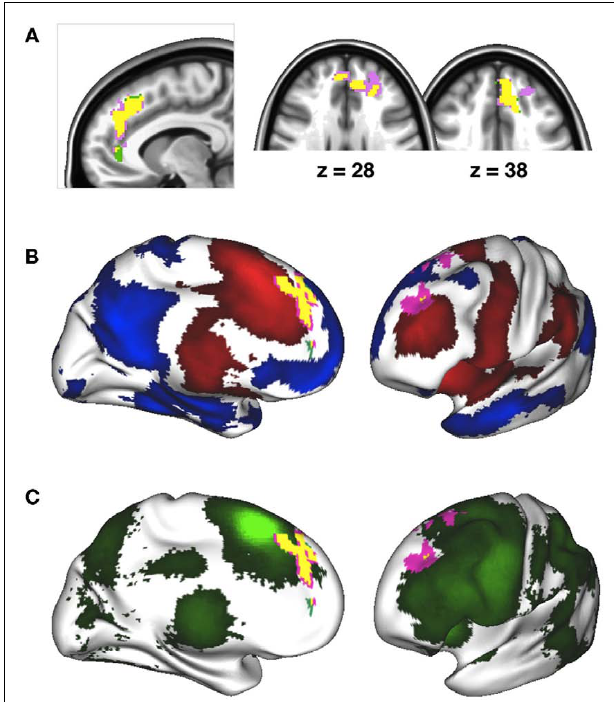
FIGURE 4 | (A) Inter-individual differences in SSRT and SSD both modulated resting state functional connectivity between right pre-supplementary motor area (pre-SMA) and a similar cluster in anterior cingulate cortex/superior frontal gyrus.Yellow indicates overlap between the cluster exhibiting a significant connectivity–behavior relationship for SSRT (grass green) and the cluster exhibiting a significant connectivity–behavior relationship for SSD (pink). (B) Overlap between the connectivity–behavior clusters shown in (A) and the overall positive (red) and negative (blue) functional connectivity network maps obtained for the pre-SMA seed.The connectivity–behavior cluster was located in transition zones between areas of overall positive or negative connectivity. (C) Overlap between connectivity–behavior clusters shown in (A) and a pre-SMA task-based co-activation map obtained from www.neurosynth.org.The co-activation map is based on a meta-analysis of activation coordinates reported together with the coordinates of the pre-SMA seed region (Yarkoni et al.,